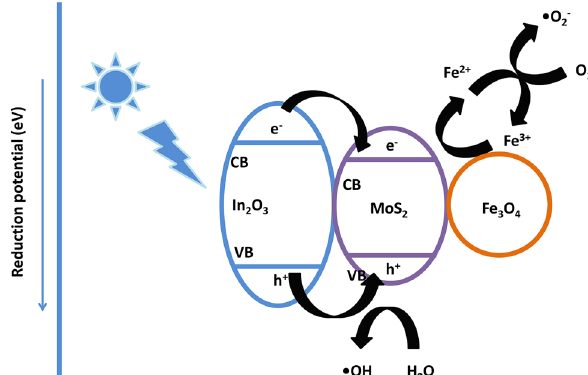
Figure 13. Plausible disintegration pathway of